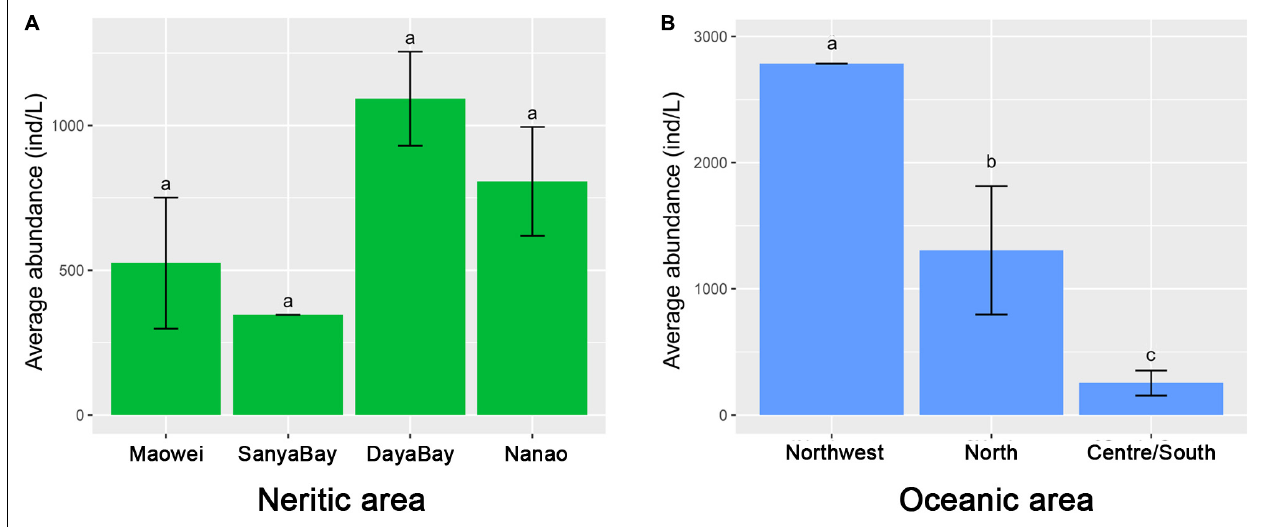
FIGURE 5 | Comparison of ciliate abundances among the subareas in neashore and oceanic areas of SCS. (A) Average abundance of ciliates in the four subareas in neritic water. (B) Average abundance of ciliates in the four subareas in oceanic water.